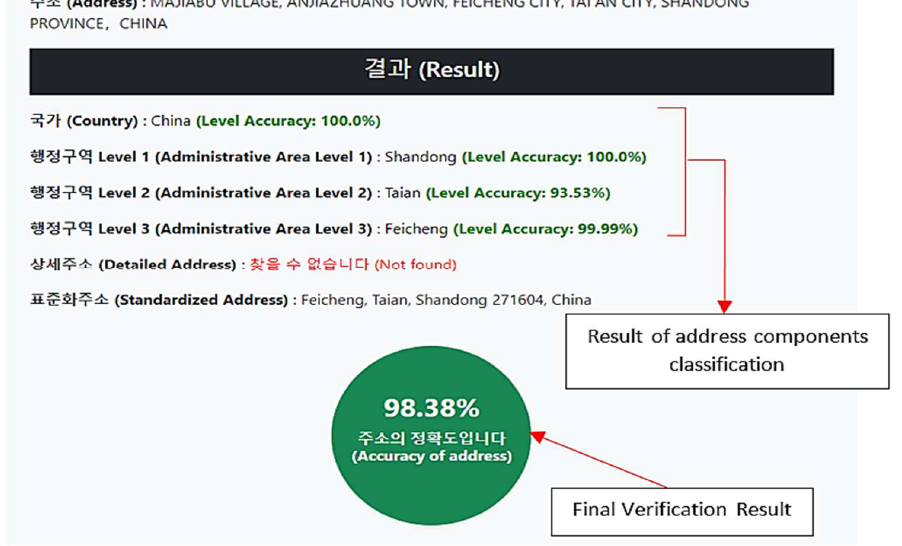
Figure 8. Verification result for a Chinese business address.